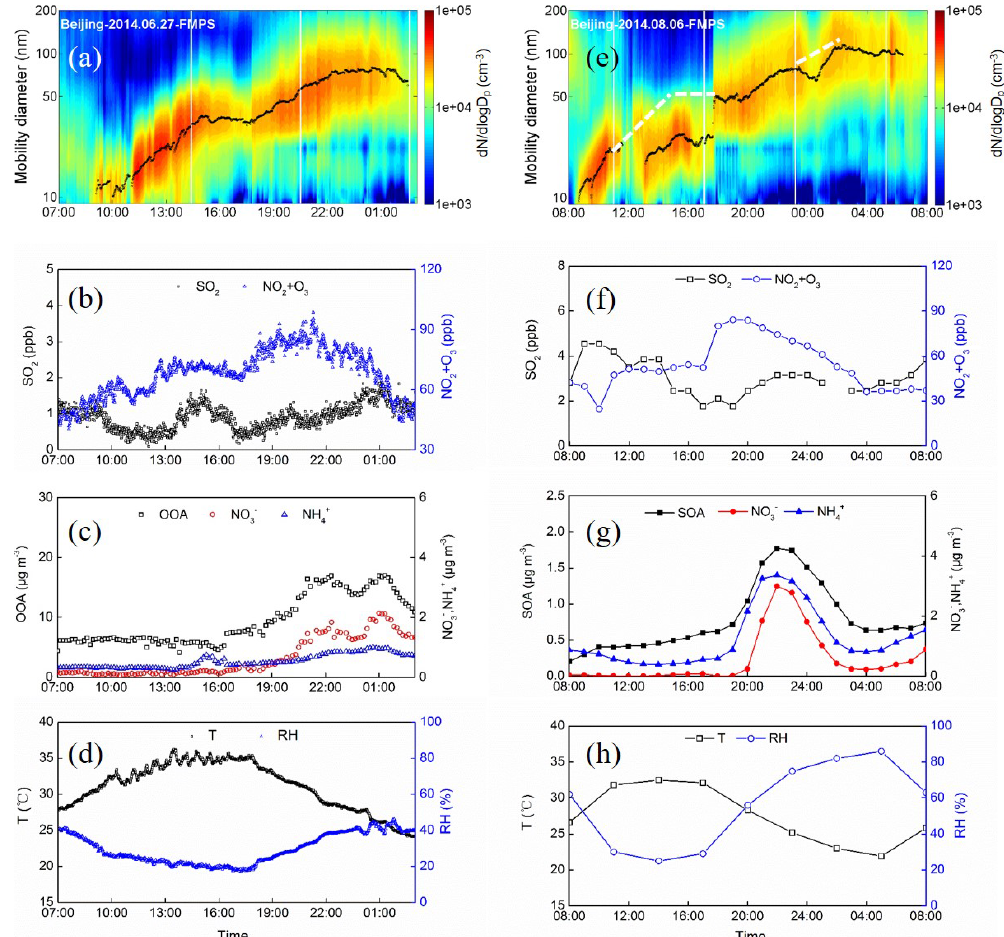
Figure 4. NPF events on 27 June and 6 August 2014. (a, e) Contour plot of particle number concentration. (b, f) Time series of observed mixing ratios of SO 2 and NO 2 + O 3 . (c) Time series of observed OOA, NO − RH. (g) Time series of modeled SOA, NO −